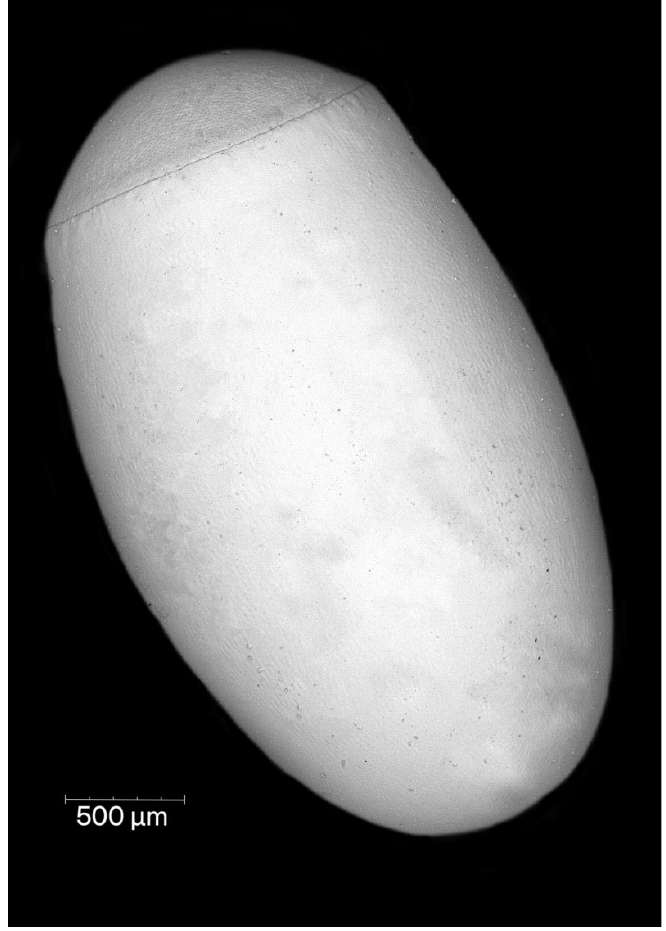
Figure 1. General view of the eggshell of Psyttala horrida (Stål, 1865).